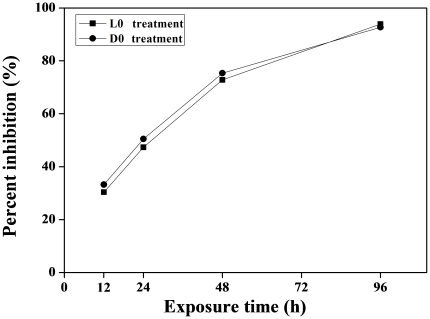
Effects of H2O2 on the inhibition of M. aeruginosa growth.